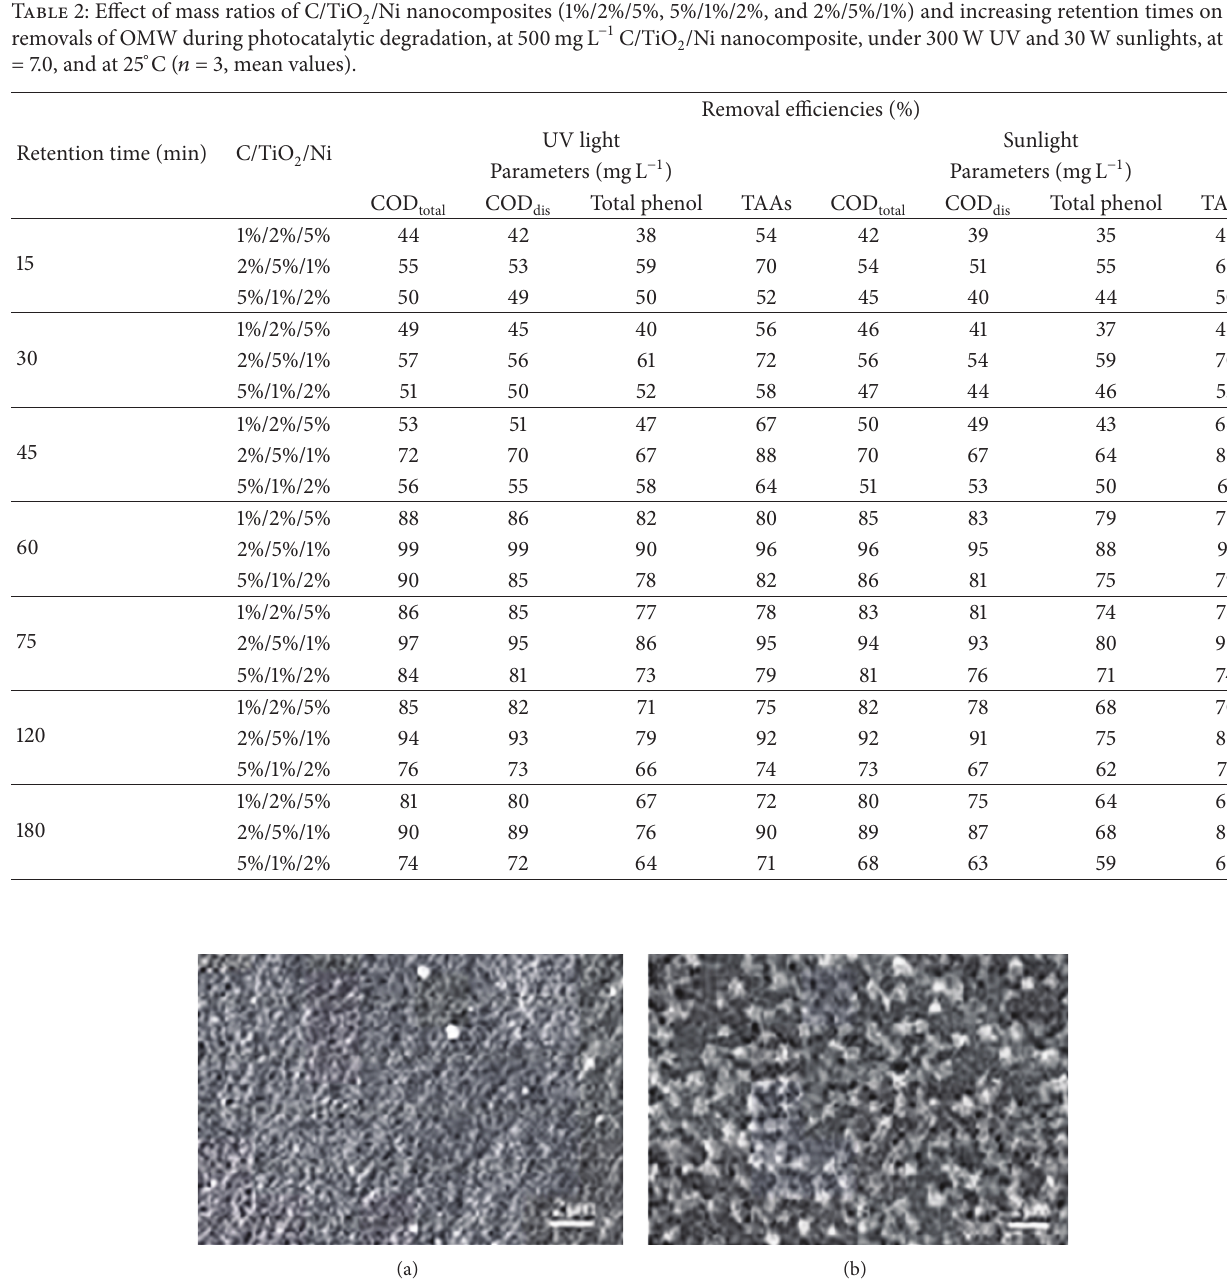
Figure 3: The SEM images of (a) a mixture of C/Ni/TiO 2 before photocatalytic oxidation and (b) the core-shell Ni/TiO 2 composite coated with polyphenols and aromatic